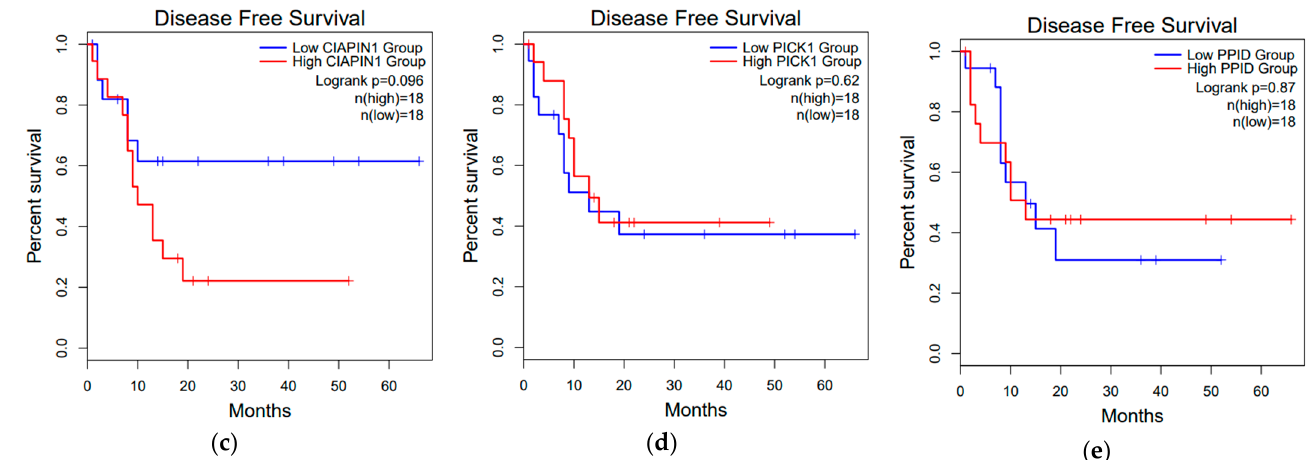
Figure 2. The prognostic information of the five selected mitochondrial proteins. The GEPIA2 online open-access gene expression database was used to see the prognostic value of mRNA expression levels of ( a ) NCOA1, ( b ) VCP, ( c ) CIAPIN1, ( d ) PICK1, and ( e ) PPID, and, out of five candidates, only CIAPIN1 was correlated significantly ( p < 0.1) with worse disease-free survival.